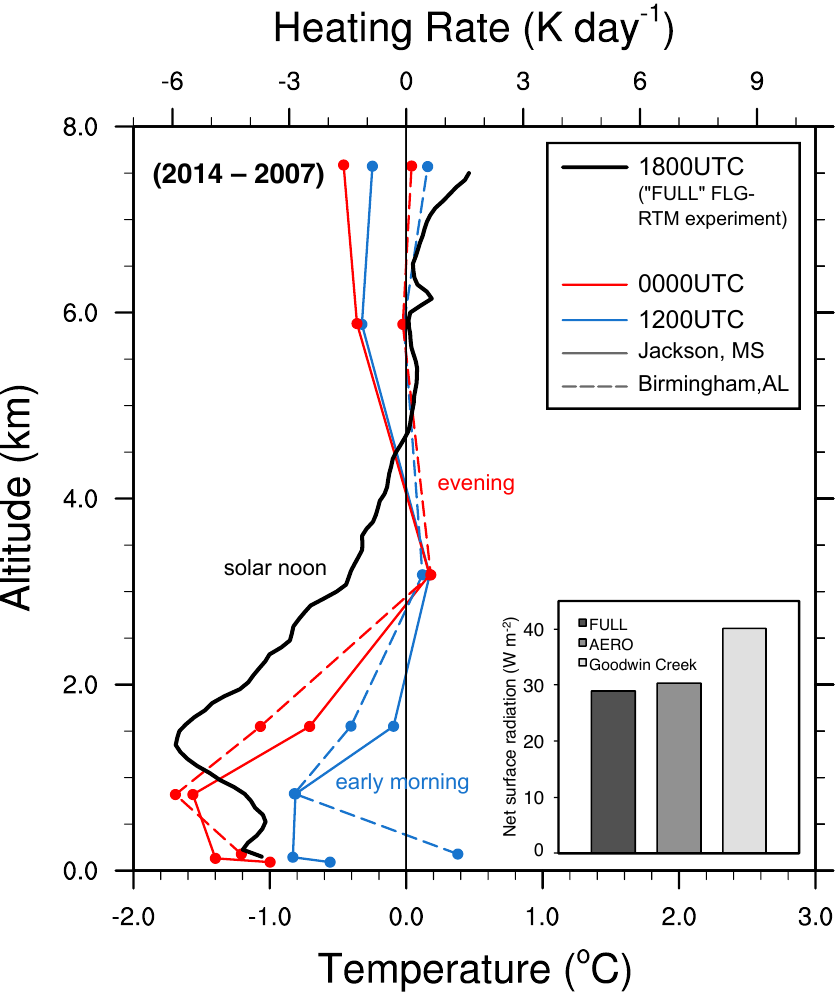
Figure 5. main: vertical profiles of the difference (2014–2007) in heating rates (thick black line) and atmospheric temperatures (red and blue lines) in SEUS from the ’FULL’ FLG-RTM (Fu-Lio-Gu Radiative Transfer Model) model experiment (black line) at solar noon (1800 UTC) and atmospheric sounding data from Birmingham, AL, USA (dashed lines) and Jackson, MS, USA (solid lines) at 8:00 a.m. local time (1200 UTC) and 8:00 p.m. local time (0000 UTC). inset: net surface radiation differences (2014 minus 2007) at solar noon from the ‘FULL’ and ‘AERO’ (see Section 2.3) FLG-RTM experiments and the integrated 1700–1900 UTC average from the Goodwin Creek, MS, USA SURFRAD (surface radiation) measuring station. Goodwin Creek values were computed by pairing the number of days and the times so that the intrinsic sampling was